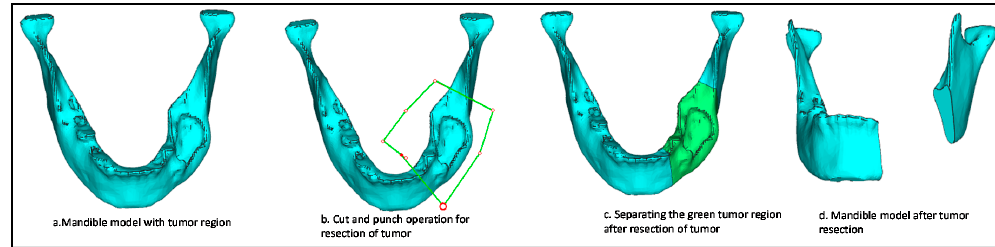
Figure 6. Design steps in the creation of resected mandible.